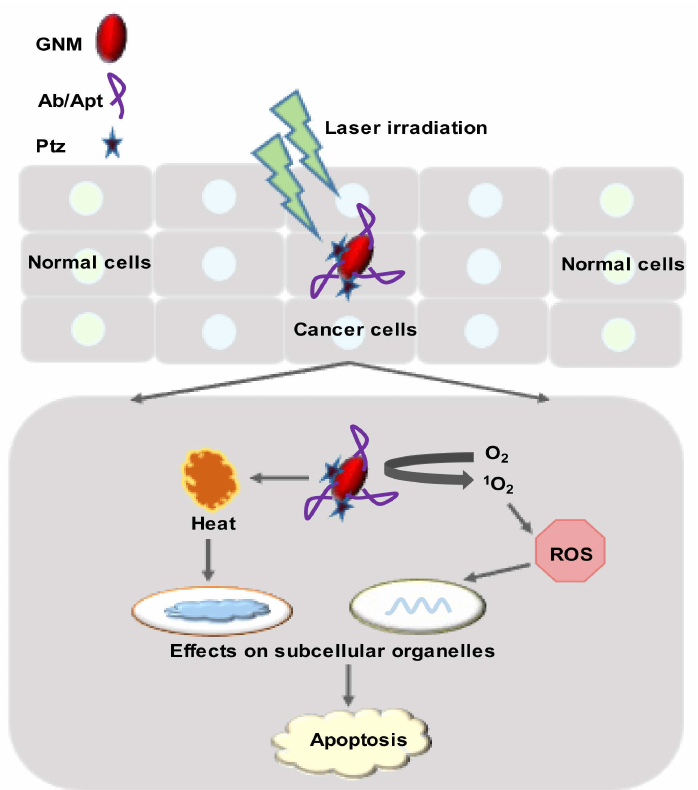
Figure 7. Schematic representation of GNM-mediated PTT or PDT effects. Apt- or Ab-conjugated GNM binds selectively with the cancer cells. GNM or the Ptz absorb the NIR laser light. Different cellular events involved in cell death induced by GNM-mediated PTT or PDT effects upon pho- toexcitation. Photothermal therapy: PTT; Photodynamic therapy: PDT; Gold nanomaterials: GNM; Near-infrared radiation: NIR; Antibody: Ab; Aptamer: Apt; Reactive oxygen species: ROS. Yang et al. (2014) [96] loaded anti-CD138 antibody (anti-CD138-Ab) on the surface of PEG-modified hollow AuNPs (anti-CD138-Ab-PEG-AuNPs) that selectively target A20 lymphoma cells. Treatment of female BALB/c mice with